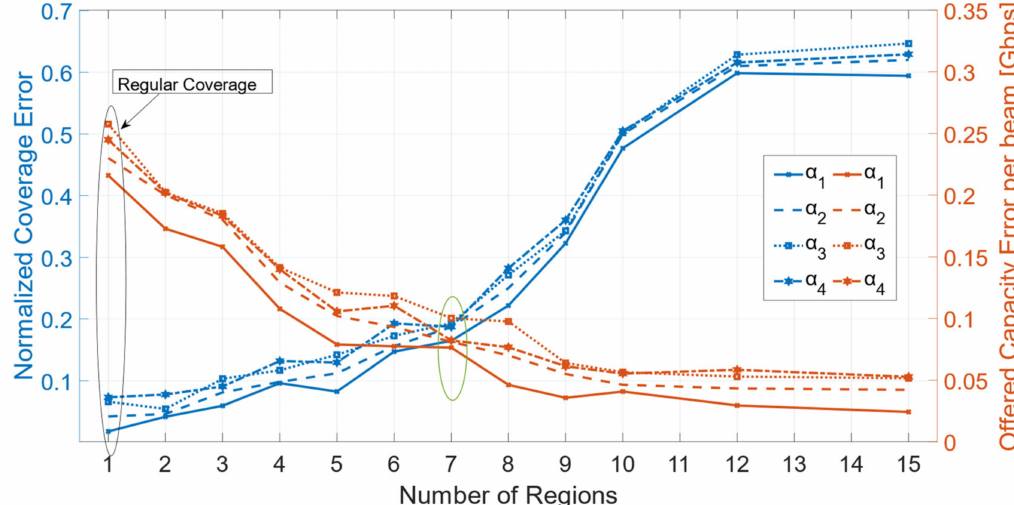
Figure 12. Performance based on the number of regions into which the service area is divided and grid orientation: Normalized Coverage Error and Offered Capacity Error per beam.